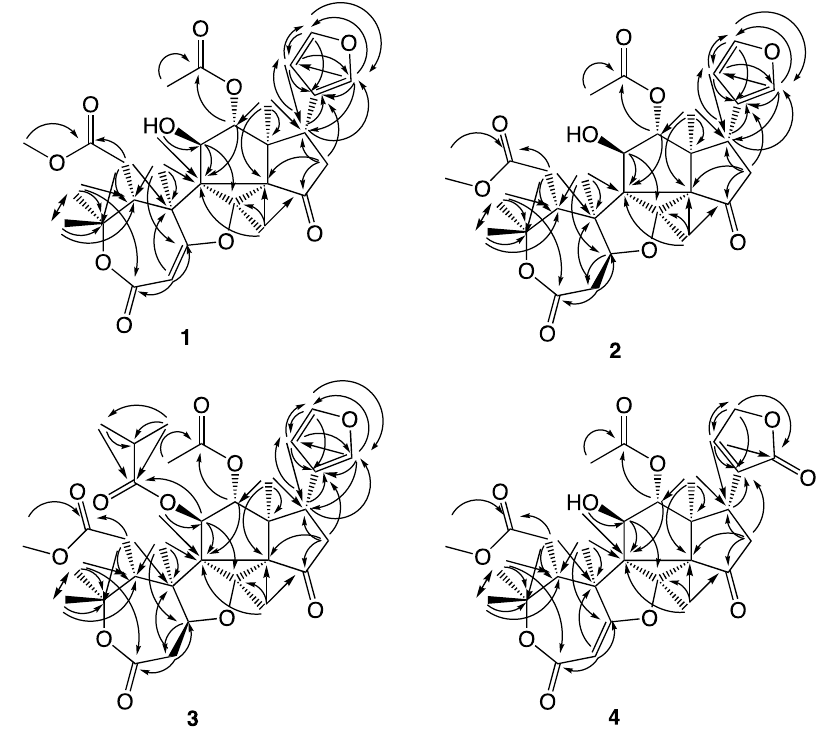
Figure 4. HMBC correlations observed with compounds 1 – 4 .